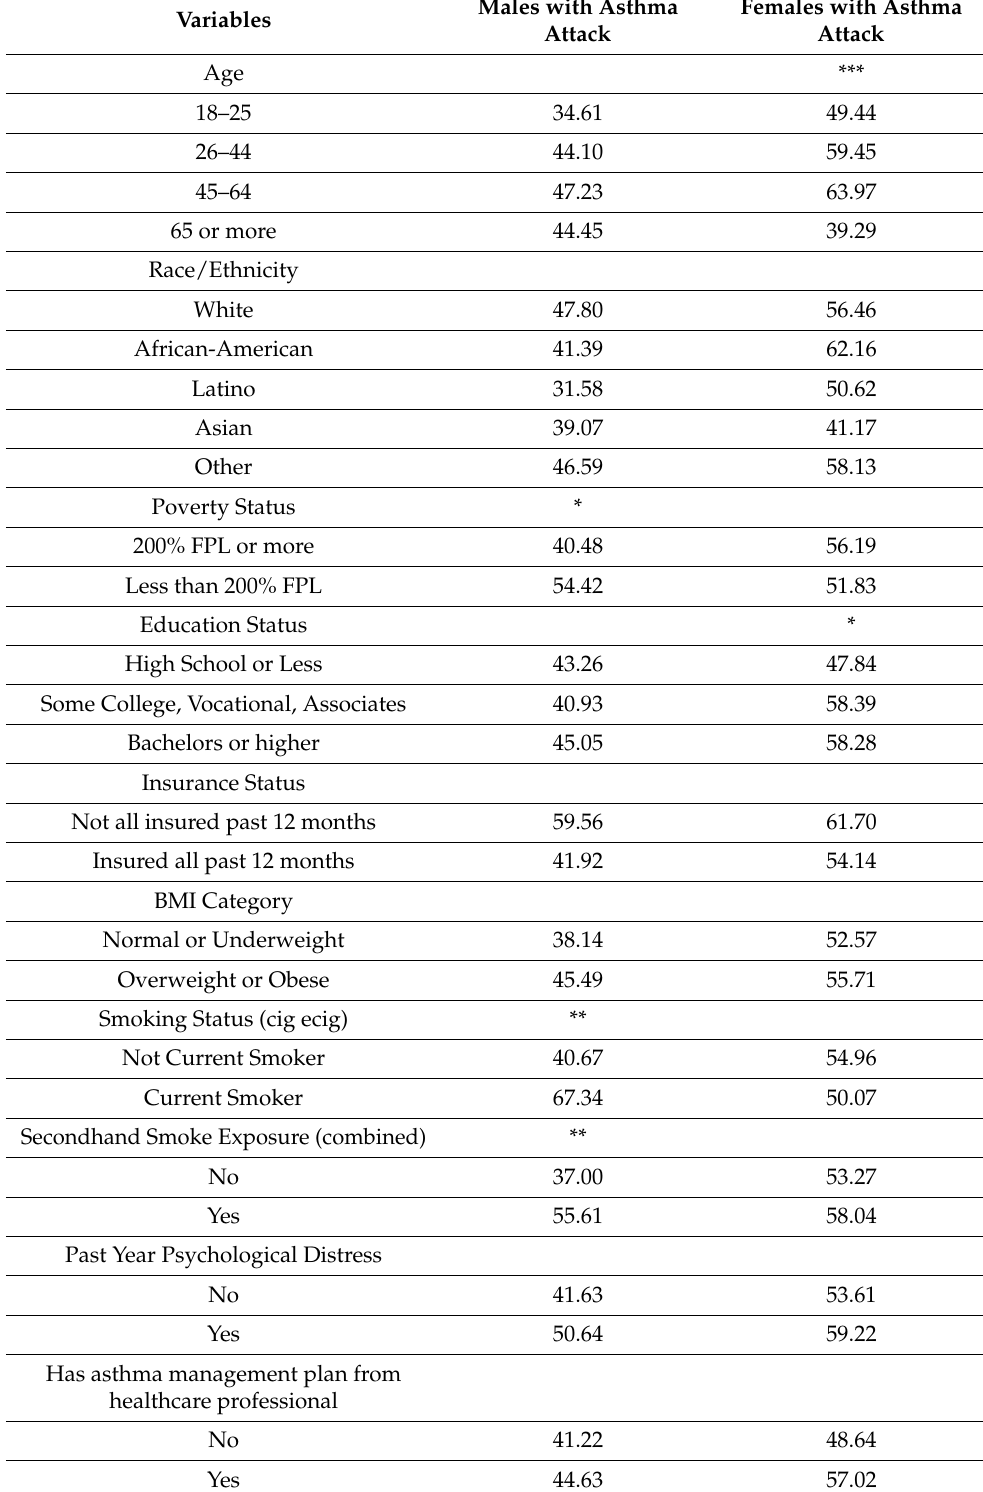
Table 2. Association between study population characteristics and asthma attack in the past 12 months, by